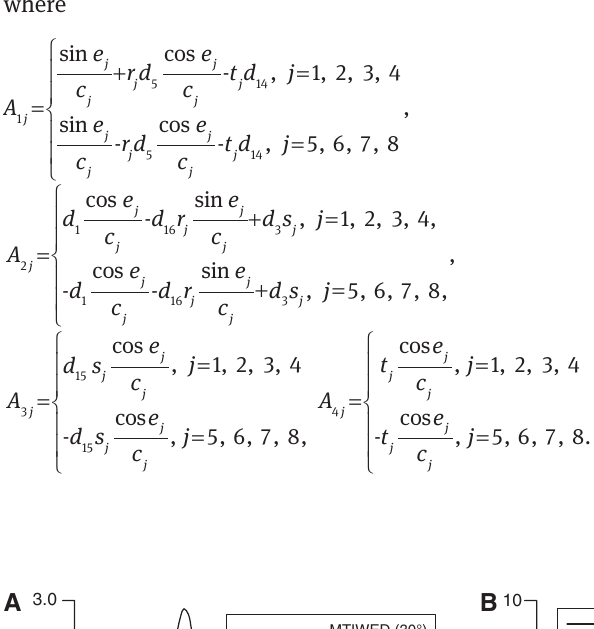
|, and (D) amplitude ratio | Z 3